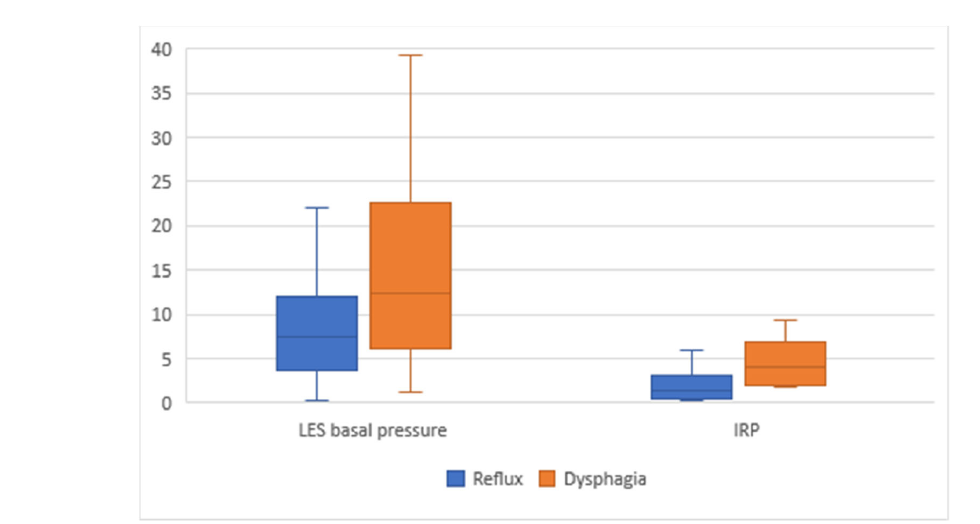
Figure 2. HRM Metrics Based on Absent Contractility Phenotype.